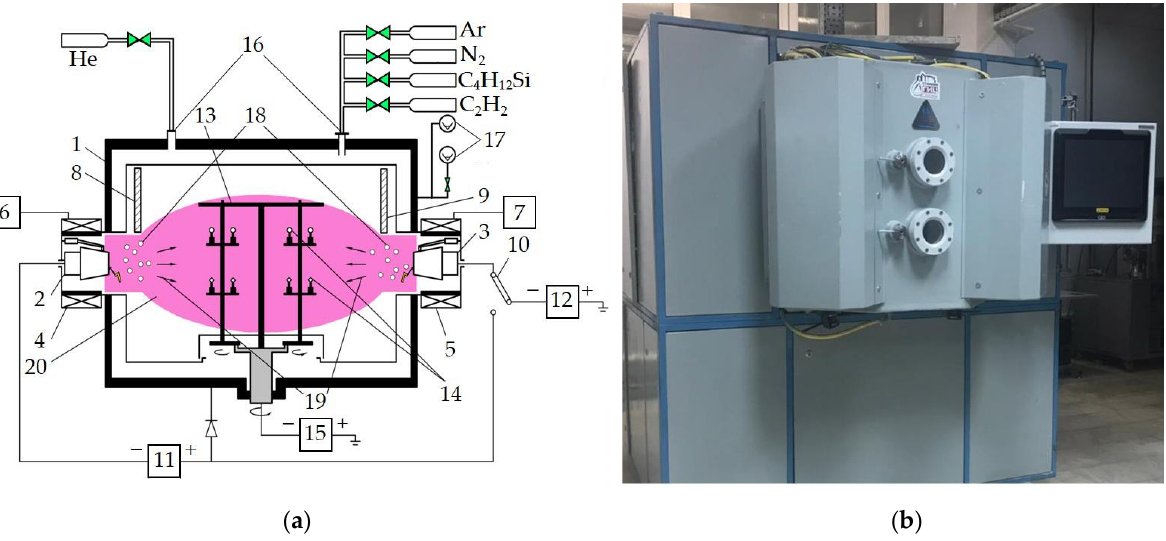
Figure 3. ( a ) Schematic diagram of the STANKIN technological unit for coating ceramic inserts, where 1 is vacuum chamber; 2,3 are cathodes (Cr and AlSi); 4,5 are cathode coils; 6,7 are power sources of cathode coils; 8,9 are cathode shutters; 10 is switchboard; 11,12 are cathode current sources; 13 is equipment for placing samples with planetary rotation; 14 is ceramic inserts; 15 is reference voltage power supply; 16 is gas supply systems; 17 is vacuum gauges; 18 is ions; 19 is ion movement directions; 20 is plasma; ( b ) a general view.